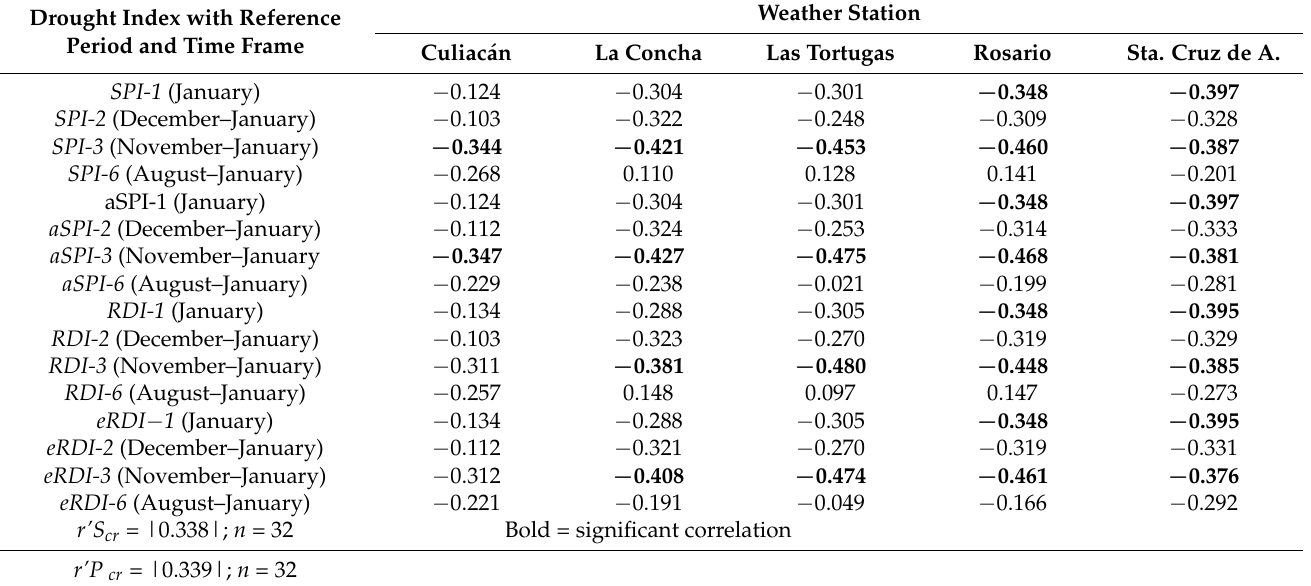
Table 3. Coefficients of r’P and r’S , between the SPI , aSPI , RDI and eRDI indices, and RMY ob .